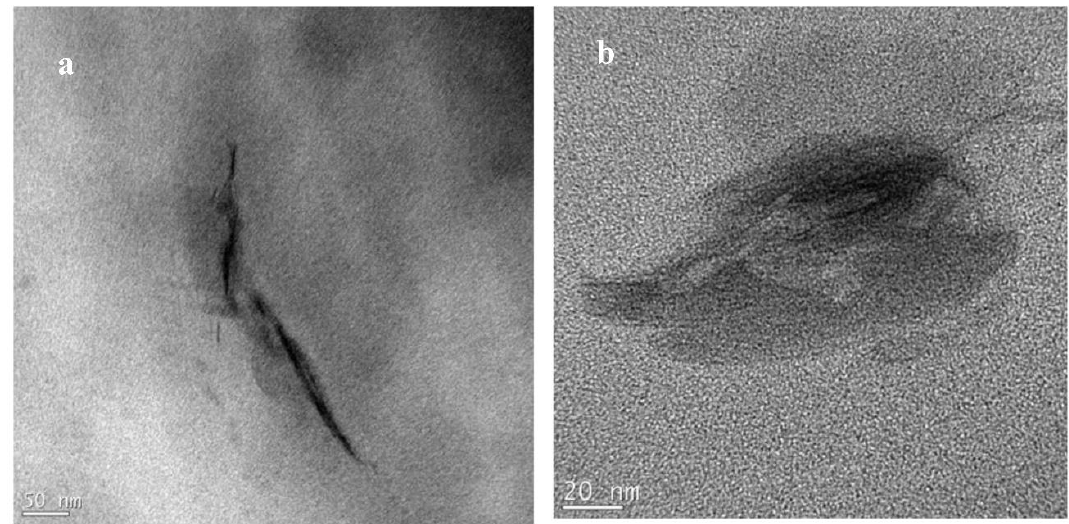
Figure 11. ( a , b ) TEM micrographs for N6-Na + prepared by static melt annealing showing unevenly dispersed clay particles in different regions in the sample.